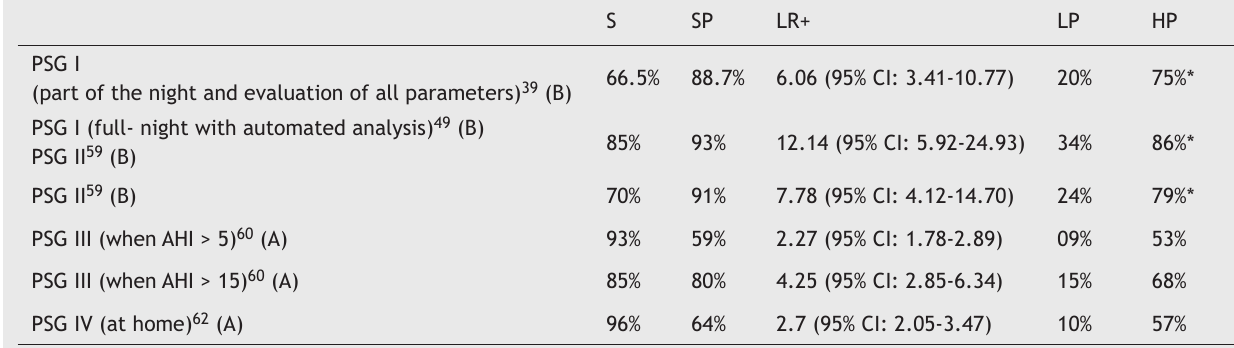
Table 4 Sleep monitoring methods and diagnostic probability according to the prevalence of the